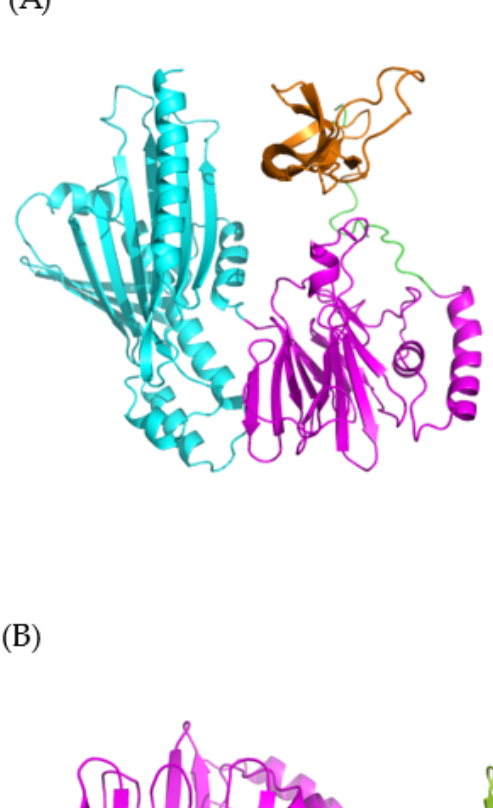
Figure 4. Deduced amino acid sequence alignment of TTX binding protein, HSTBP, with clotting proteins of shrimp and crab from the suborder Pleocyemata. Accession numbers for clotting pro- teins (DDBJ/EMBL/GenBank databases): XP_045118682.1 for Portunus trituberculatus ; AYK27566.1 for Scylla paramamosain ; KAG7156252.1 for Hormarus americanus ; AAD16454.1 for Pacifastacus leniusculus ; AYD41596.1 for Procambarus clarkii . The residues identical with those of HSTBP are shown by gray and gaps by dashes. Signal peptides are boxed in straight lines. Cysteine residues are highlighted in white on a black background. Putative N-glycosylation sites are indicated by closed circles. Amino acid numbers are shown at the left and right.